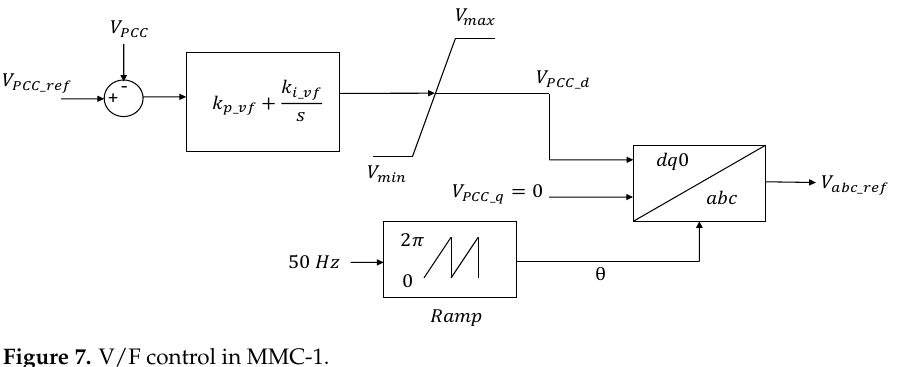
Figure 7. V/F control in MMC-1.